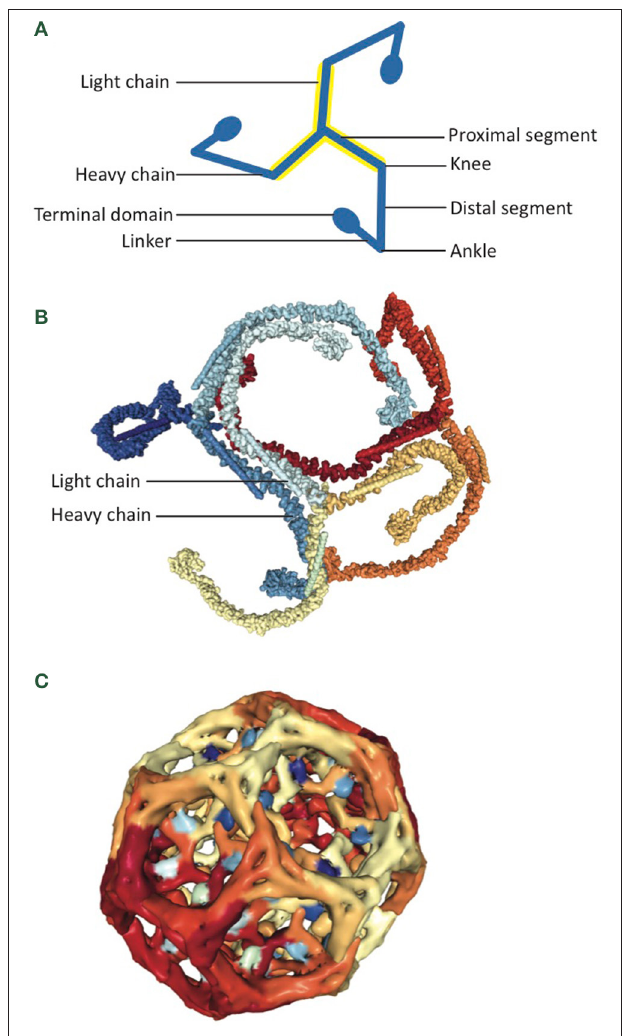
FIGURE 3 | Auxilin is an Hsc70 co-chaperone for clathrin uncoating. (A) Cartoon depicts structure of a clathrin triskelion. Three clathrin ankle segments cross to form a stable clathrin cage. (B) Assembled clathrin coat containing clathrin heavy chain and clathrin light chain, as determined by electron microscopy (PDB:3IYV; Fotin et al., 2004b). (C) The J domain of auxilin (shades of blue) interacts with the clathrin coat (shades of red and yellow; PDB: 1XI5; Fotin et al.,